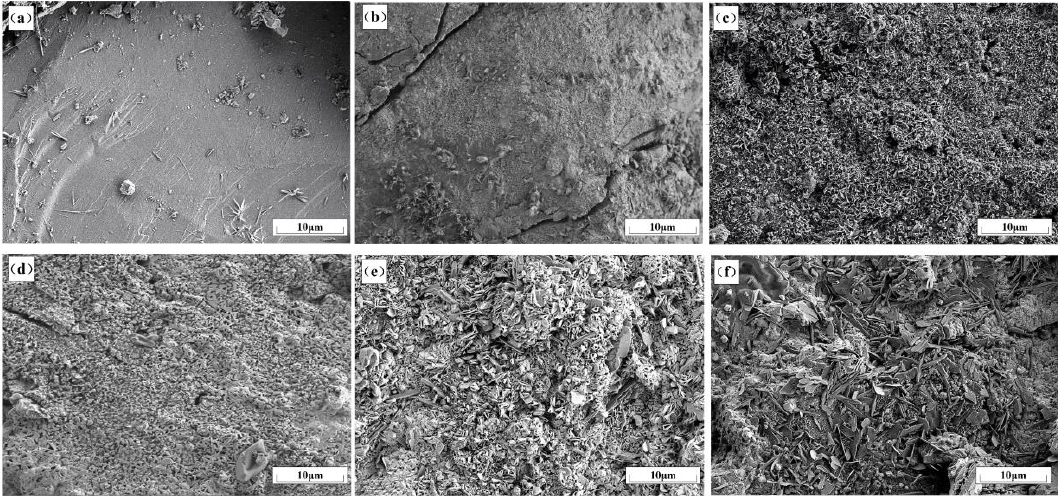
Figure 8. SEM morphology of nickel slag samples after oxidation for 20 min at different temperatures ( a ) 300 °C; ( b ) 400 °C; ( c ) 500 °C; ( d ) 700 °C; ( e ) 900 °C; ( f ) 1000 °C.